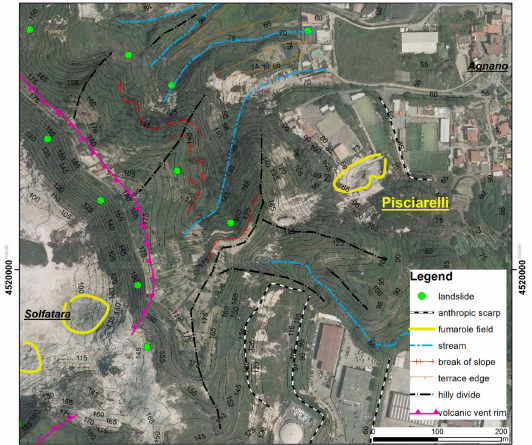
Figure 3. Geomorphological map of the Pisciarelli